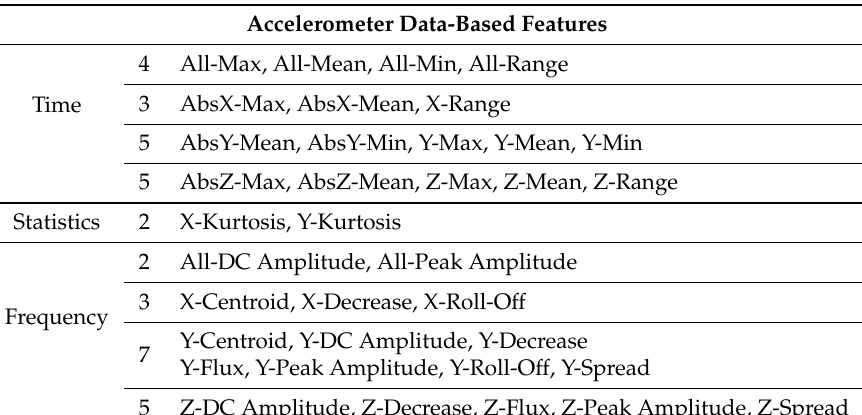
Table 4. Features extracted on accelerometer data. Abs, absolute